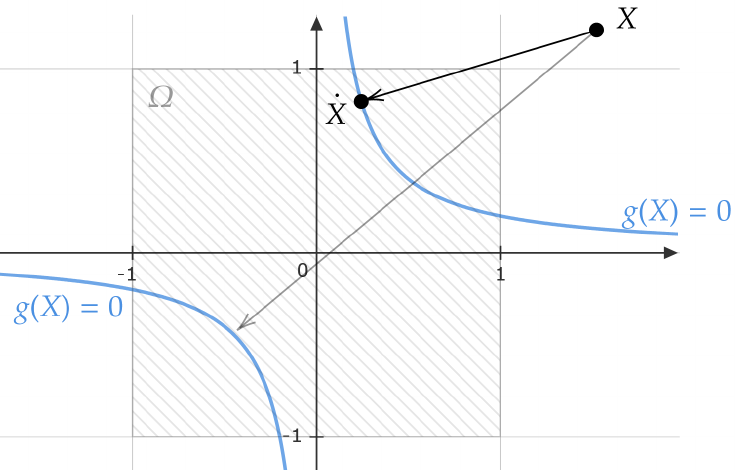
Figure 1. Visualization of the constraints for the two-asset/one-factor/one-market-constraint case. The inequality constraint Ω spans the gray box of mathematically feasible solutions, and the blue line defines the solutions which satisfy the market constraint. As can be seen, the market constraint actually consists of two convex curves. Hence, two orthogonal projections of X onto g ( X ) = 0 exist, but only one (i.e., ˙ X ) has minimum distance to X